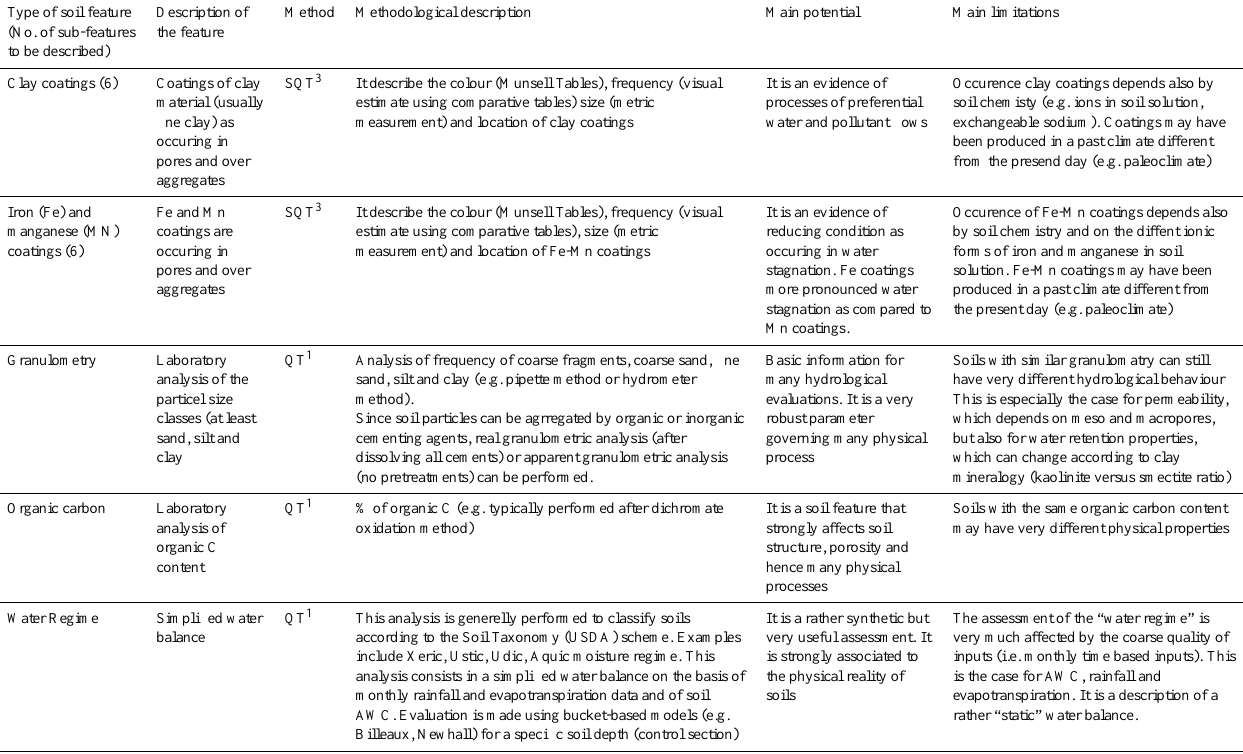
Table 3c. Types of data of great (direct and indirect) hydrological interest contained in soil map